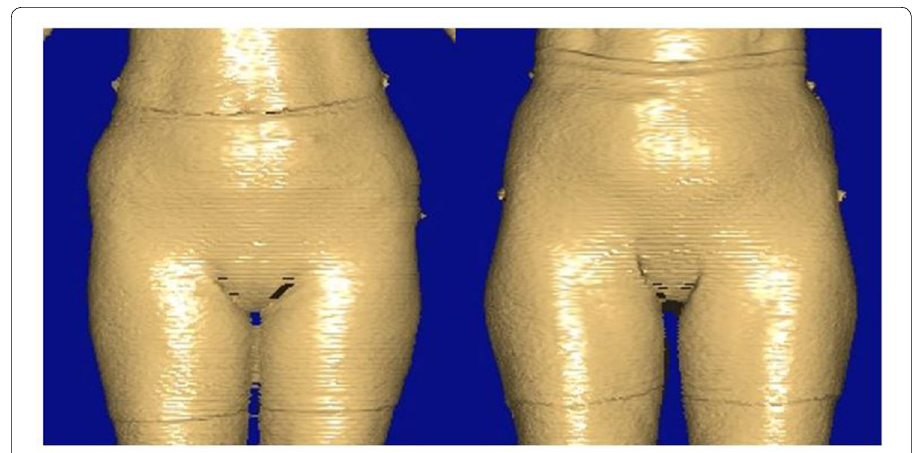
Fig. 13 Examples of GLBSP location, from left: high-hip,